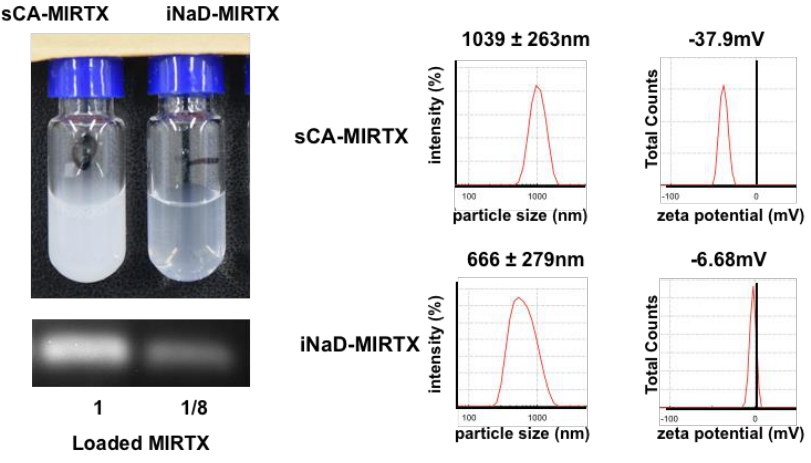
into HT29 tumor-bearing mice (tumors = 8 from 4 mice). Ex vivo IVIS imaging of the tumor and liver was performed 1 h after the injection. ( B ) Quantitative analyses of tumor and normal tissues (liver, spleen, lung, heart, kidney). Data represent mean ± SEM (n = 4 normal tissues from 4 mice, n = 8 tumors from 4 mice). p -values were obtained using the two-tailed t